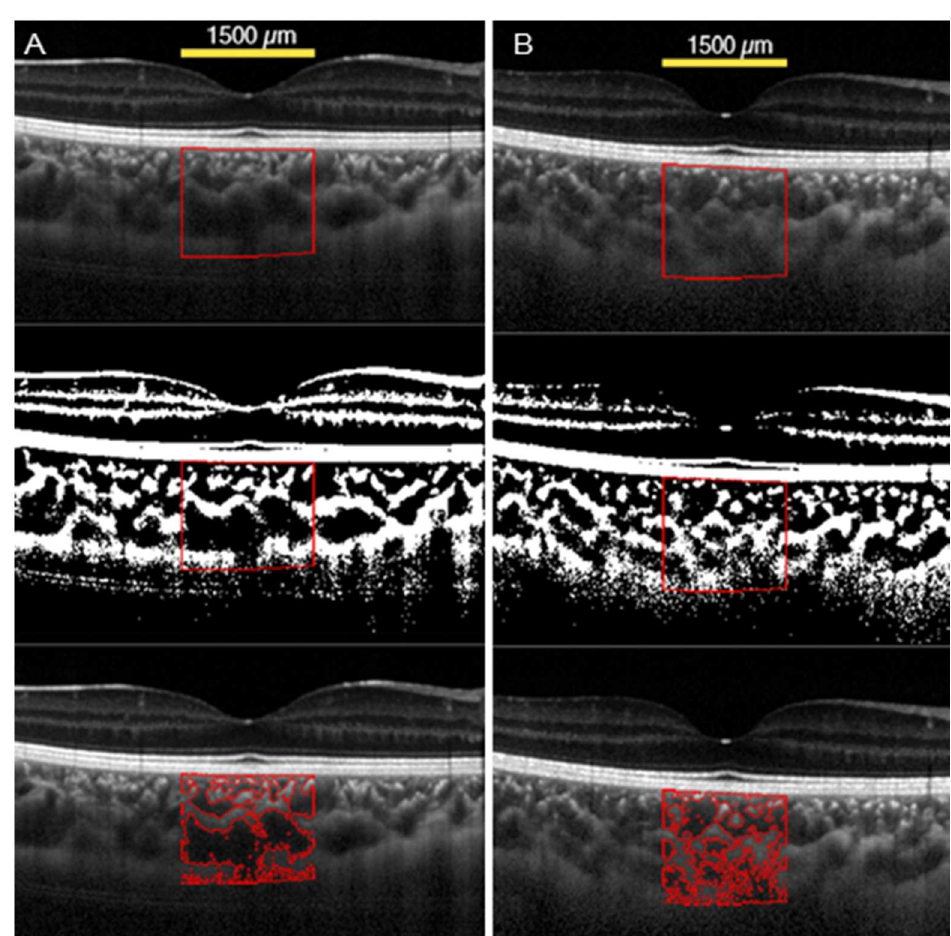
Fig 1. Enhanced depth spectral-domain optical coherence tomographic (EDI-OCT) images of the choroid of an amblyopic eye and a control eye. (A) Representative image of the amblyopiceye. The amblyopiceye has large luminal area. (B) Representative image of the control hyperopic eye. The control hyperopic eye has small luminal area. The choroidal area measured was 1500 μ m wide with the margins 750 μ m nasal and 750 μ m temporal to the fovea. Vertically, the area extended from the retinal pigment epitheliumto the chorioscleral border (yellow line). The measuredarea of the choroidis demarcated(Top). The image is convertedto a binary image by the Niblack method of ImageJ (Middle). The dark area which is luminalarea is traced by the red line